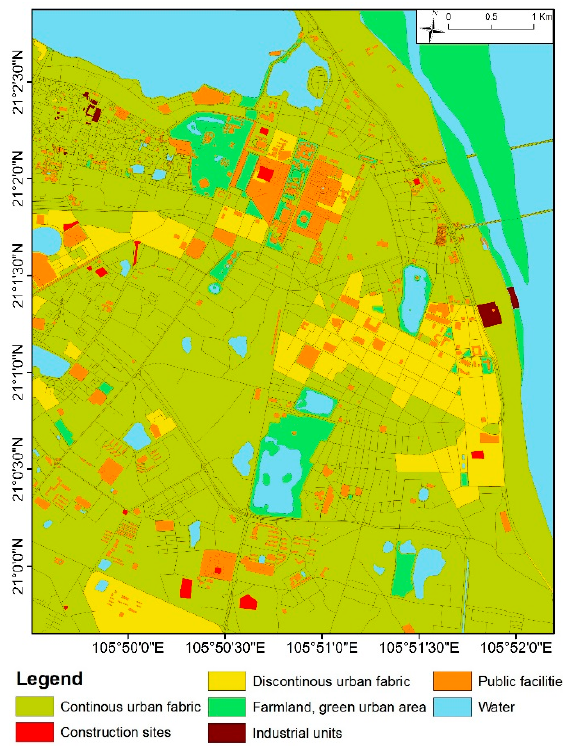
Figure 5. Land cover map of the Historical Centre of Hanoi, provided by Hanoi Environment and Natural Resources Department.